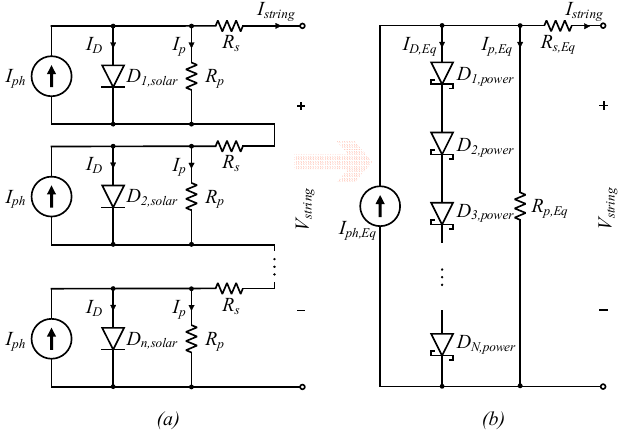
Figure 5. Simplification of the equivalent circuit. ( a ) Series string PV module circuit; ( b ) Reconstructed